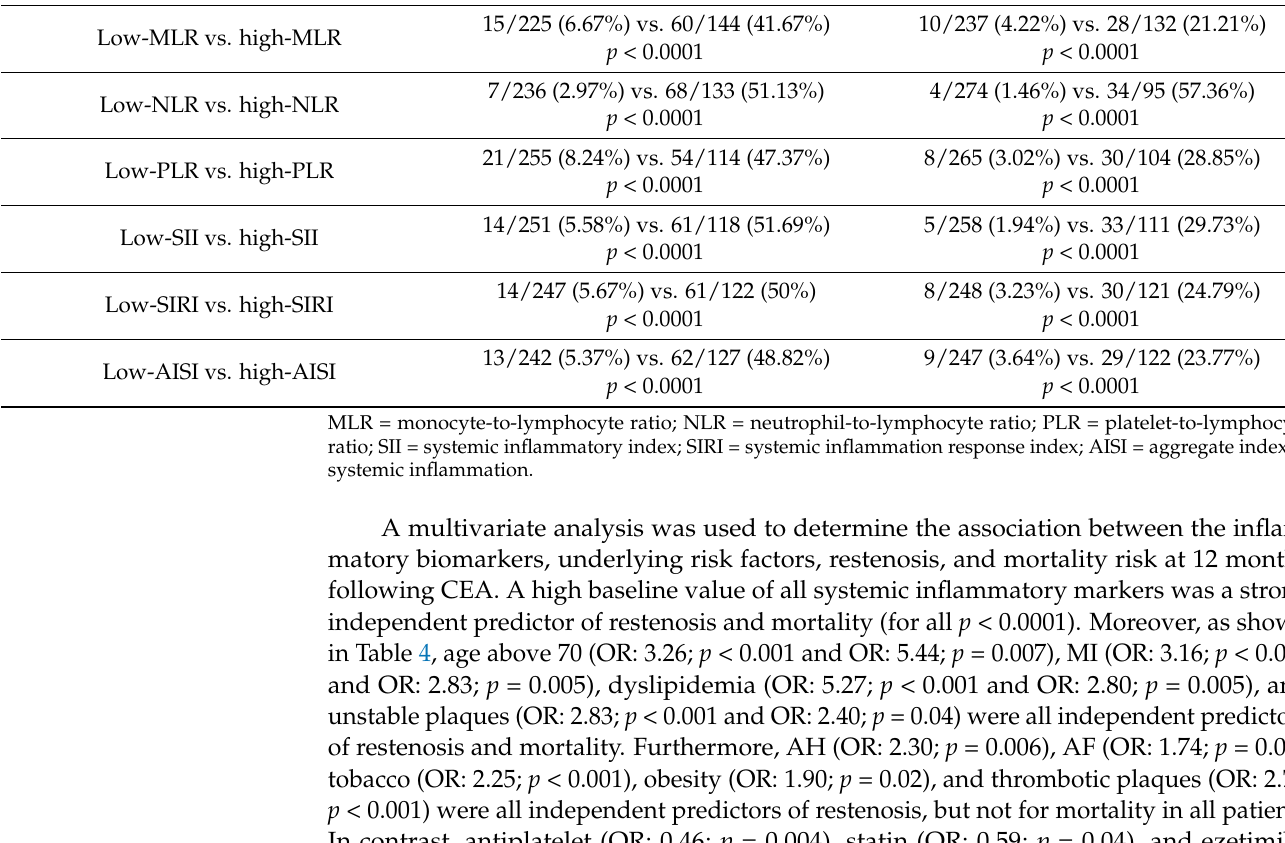
mortality rate for all the inflammatory biomarkers, as seen in Table 3. Table 3. Univariate analysis of inflammatory biomarkers and restenosis risk and mortality. Restenosis Mortality Low-MLR vs.